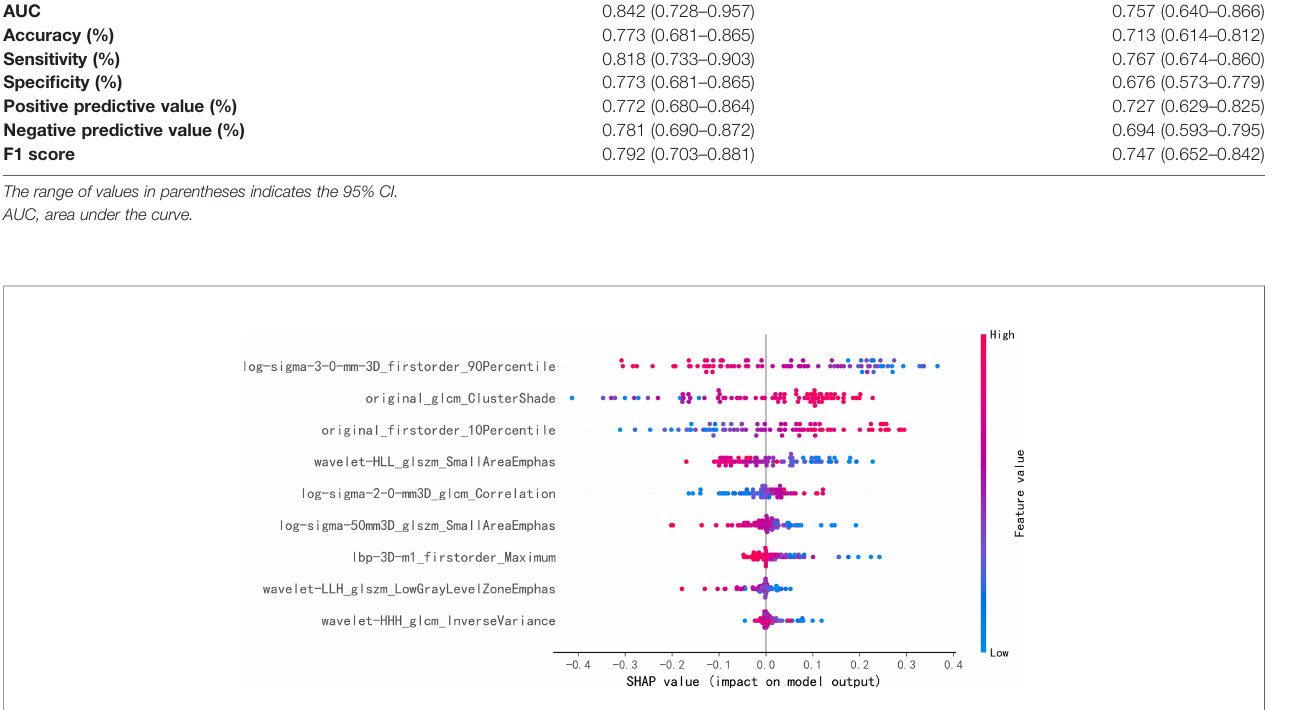
Training set Test set